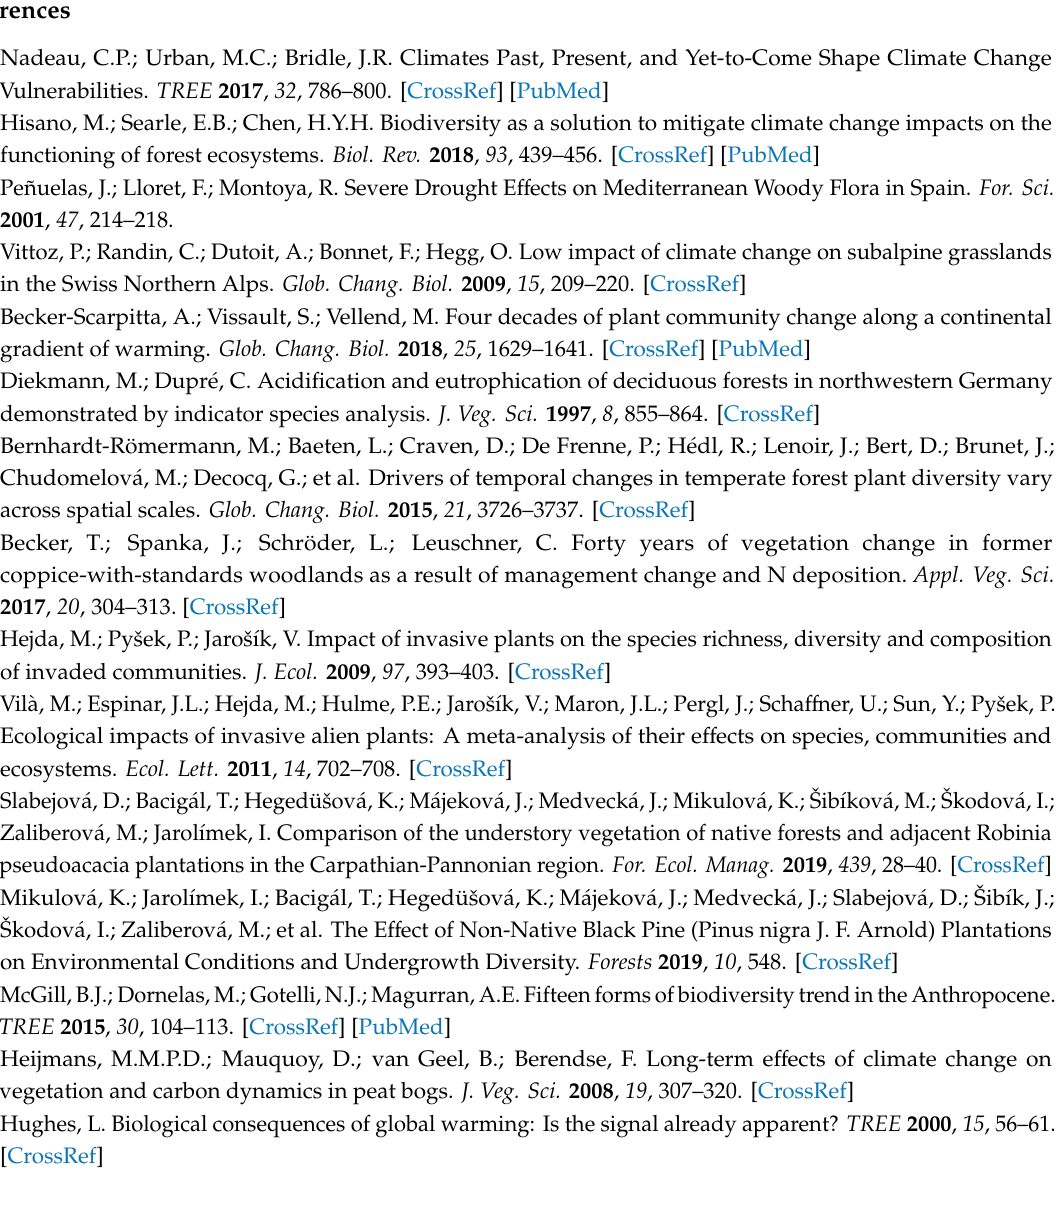
Table S1: Changes in frequencies of species in all studied plots (number of occurrences, Nmax = 76). Table S2: Changes in frequencies (% of plots occupied) of plant species in three studied types of oak–lime–hornbeam forest in the Białowie˙za Forest, Eastern Poland. Table S3: Changes in frequencies of tree species in stand in all studied plots (number of occurrences, N =